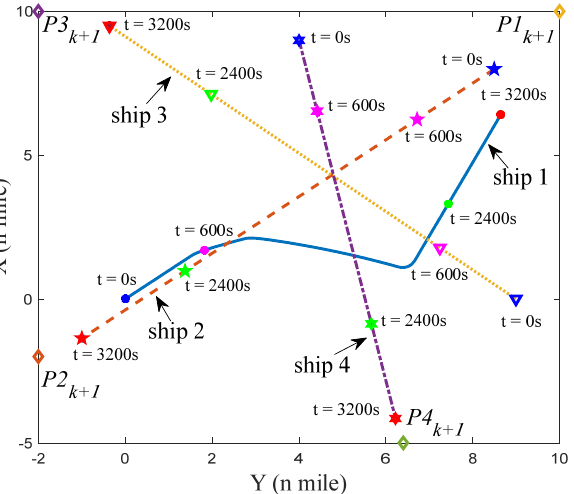
Figure 27. The situation of four ships at t = 3200 s in scenario 3 under environment disturbance.